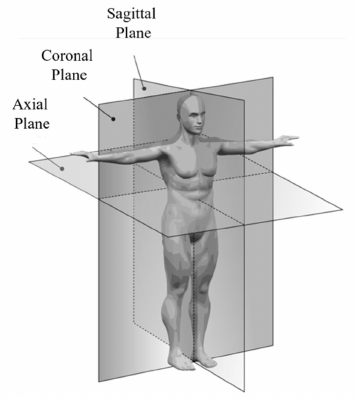
Figure 3. CT scan planes.